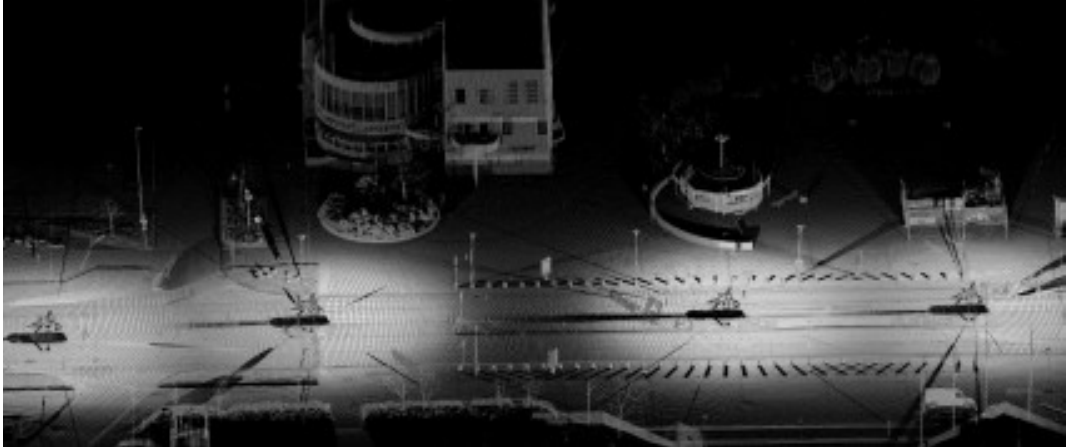
Figure 3. An example of reference point clouds. The scanning locations can be seen as shadows on the road that by the car was driven